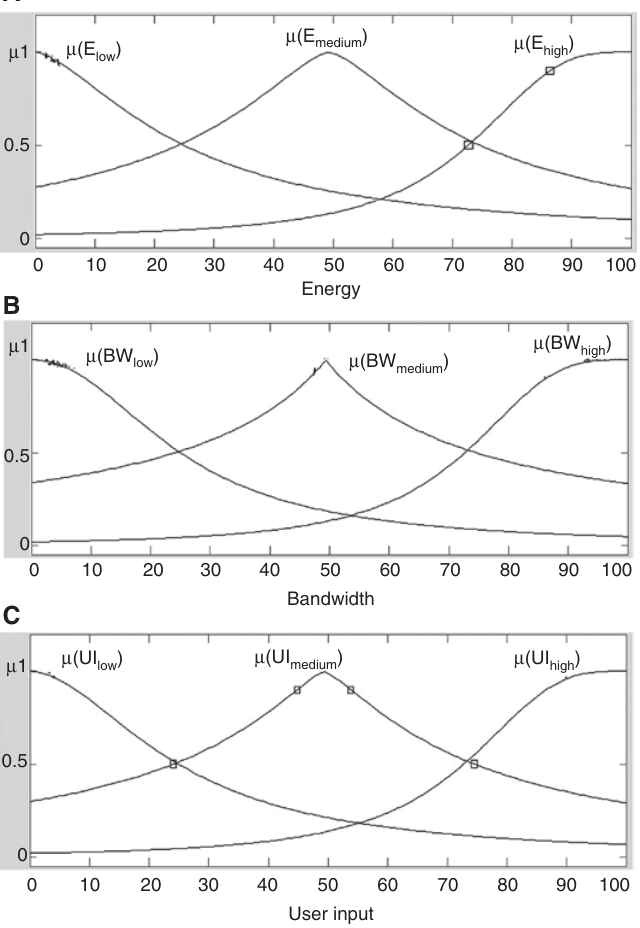
Figure 3: Membership Functions. (A) Energy input. (B) Bandwidth input. (C) User